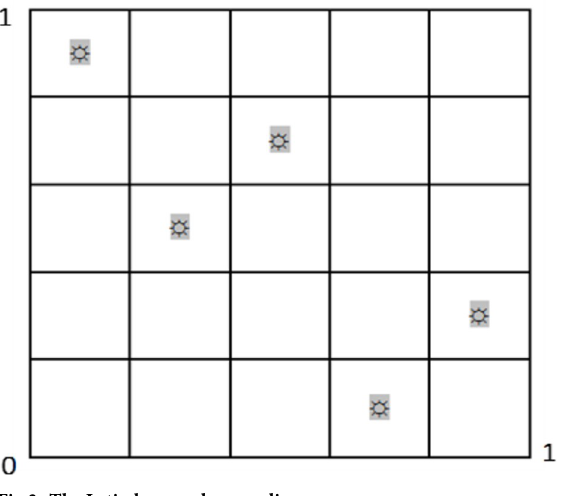
Fig 3. The Latin hypercube